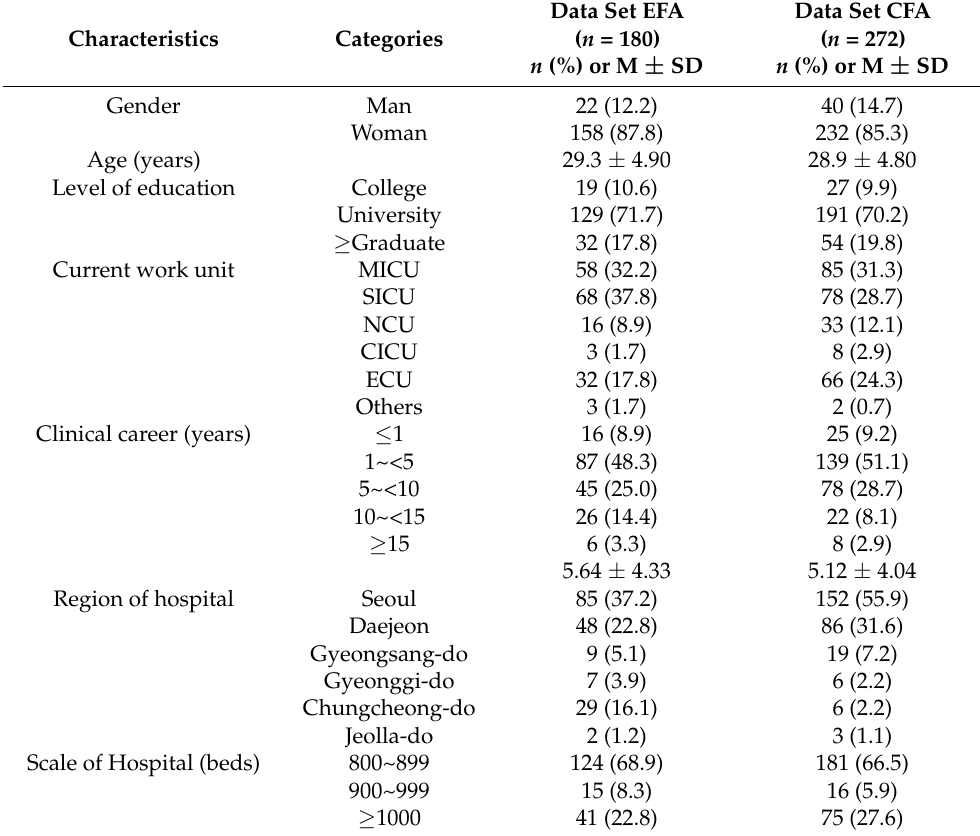
Table 1. Demographic characteristics of